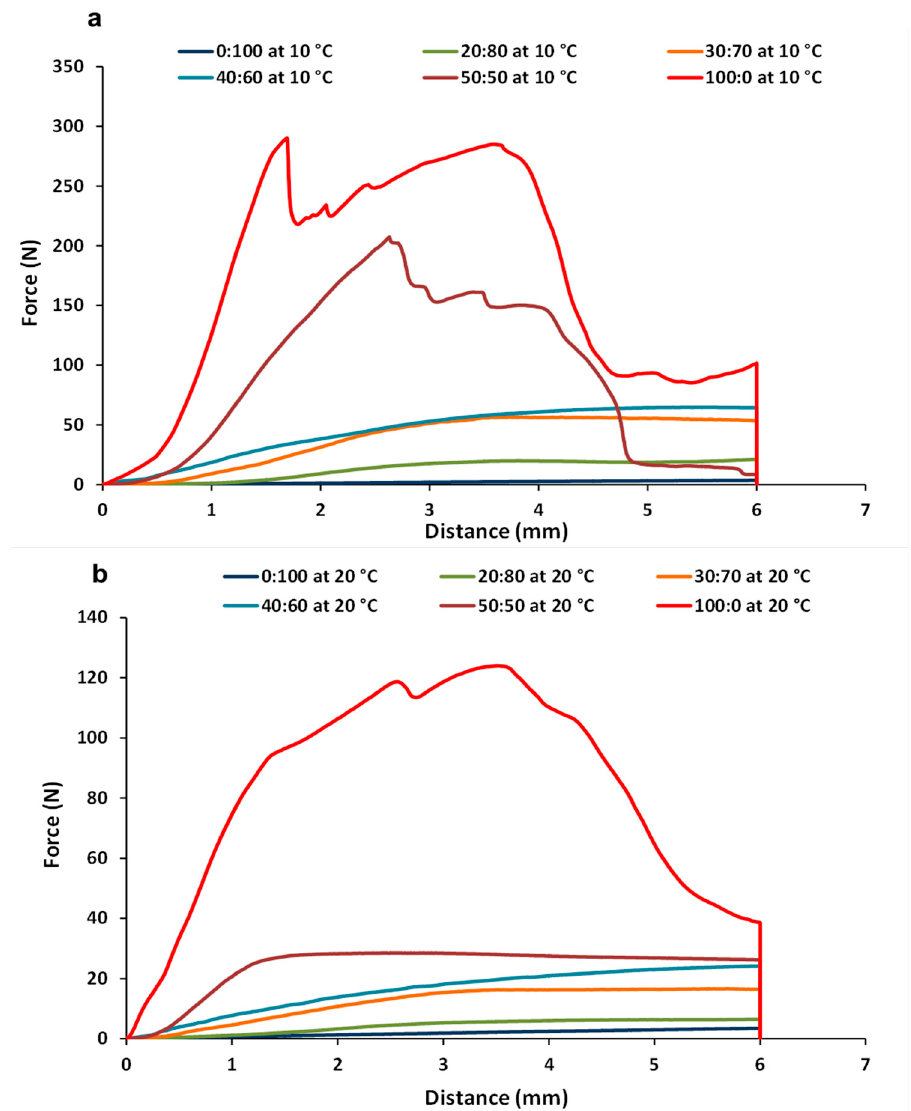
Figure 5. Force-distance curves of the different formulated CB:OG systems measured: ( a ) at 10 °C; ( b ) at 20 °C.